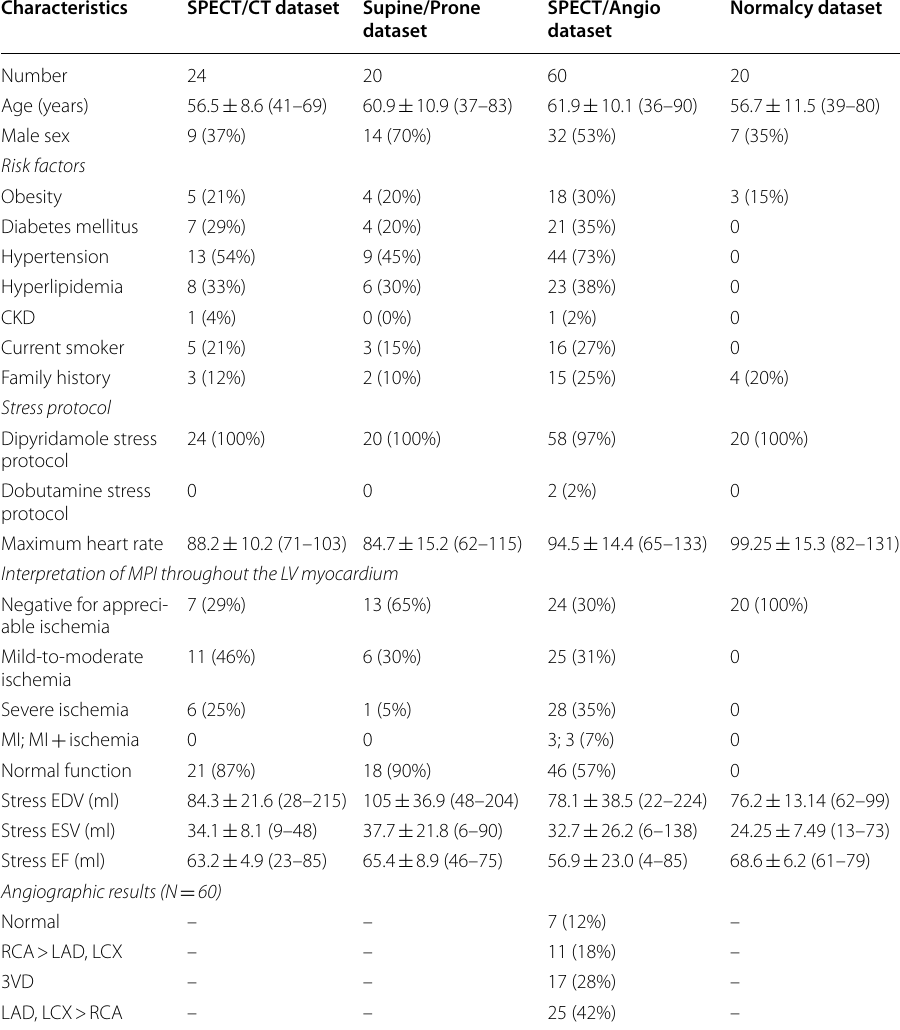
Values are presented as mean SD (range) or N (%) as appropriate ± CKD Chronic kidney disease, EDV End-diastolic volume, ESV End-systolic volume, EF Ejection fraction, LV Left ventricular, MPI Myocardial perfusion imaging, MI Myocardial infarction, LAD Left ascending coronary, LCX Left circumference coronary,